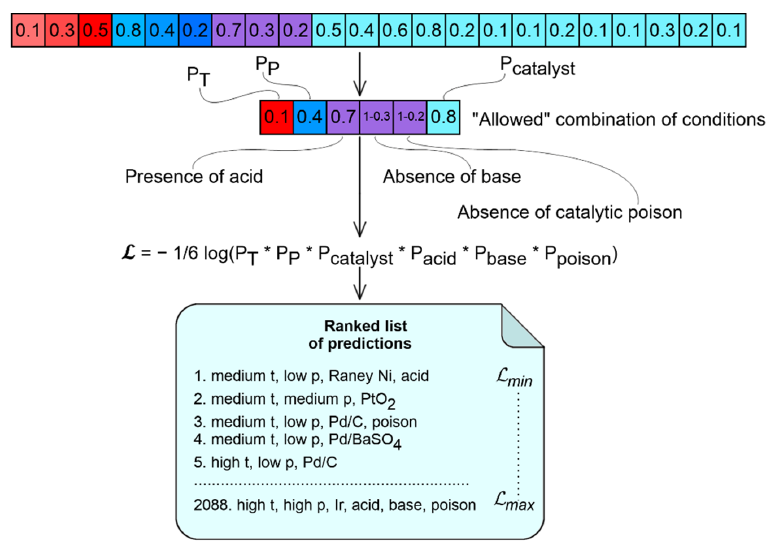
Figure 7. Example of the model predictions for a given chemical transformation. The model outputs the 38-dimentional vector corresponding to condition components shown in Figure 6. This vector is used to derive 2088 allowed combinations of conditions, each corresponding to particular temperature, pressure, catalyst, and presence of acid, base and catalytic poison. The list of allowed condition combinations is ranked according to the likelihood L